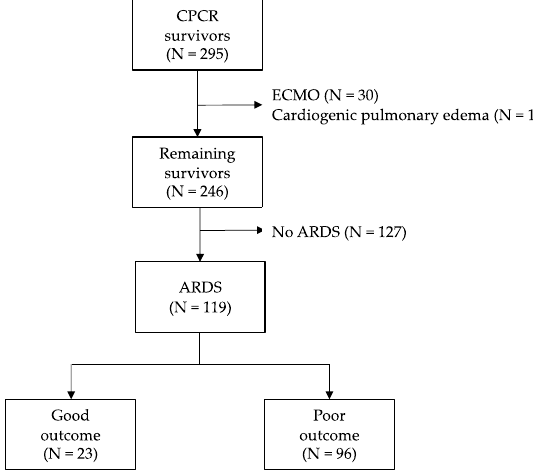
Figure1. Flowchartofthestudypopulation. Abbreviations: CPCR = cardiopulmonarycerebralresuscitation; ECMO = extracorporeal membrane oxygenation; ARDS = acute respiratory distress